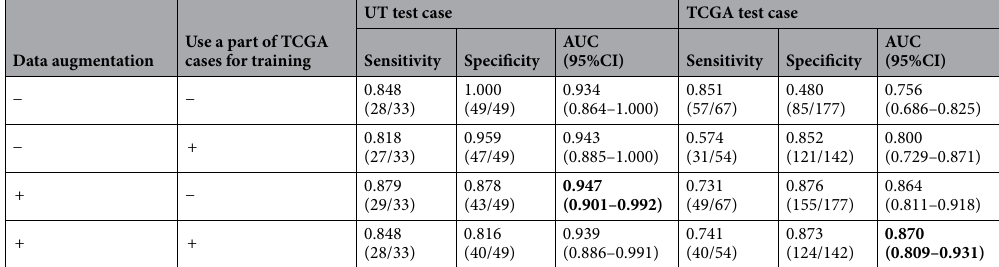
Table 4. Validation of patient-level accuracy in TCGA cases. Patient-level accuracy is shown for EBV + MSI vs. others task with and without data augmentation. The result when a part of TCGA cases (20% of all cases, randomly selected) was added to the training data and the remaining 80% of cases were used as test data is also shown. The highest AUC is indicated in bold. AUC, Area under the curve; CI, Confidence interval; EBV, Epstein-Barr virus; MSI, Microsatellite instability; TCGA, The cancer genome atlas; UT University of